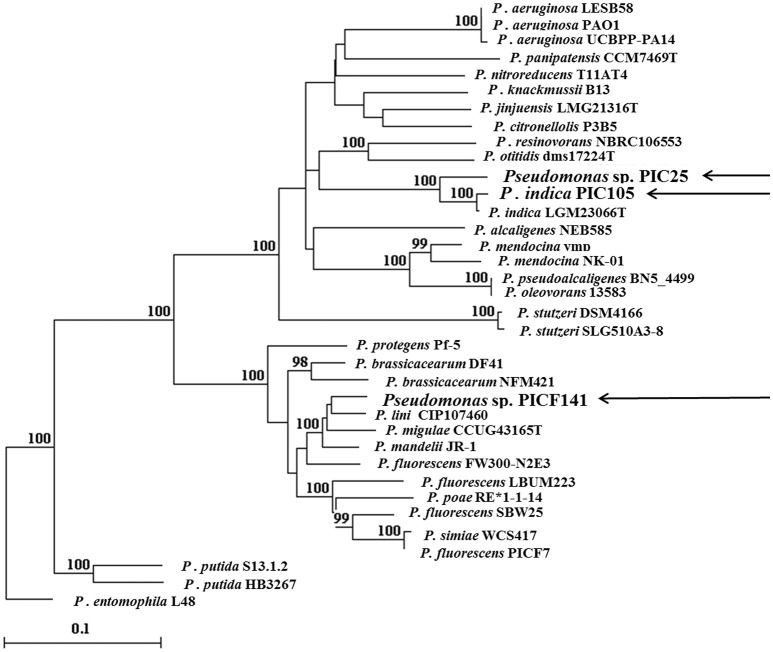
Phylogenetic tree showing the taxonomic position of the three new Pseudomonas spp. strains (arrowed) isolated from the olive rhizobacteria. The tree was inferred by the Neighbor-Joining method, based on the alignment of concatenated partial sequences of gyrB and rpoD genes (see text for details). Bar indicates sequence divergence. Bootstrap values (>95%) based on 1,000 re-sampled datasets are shown at branch nodes. Pseudomonas entomophila L48 was used as out-group.